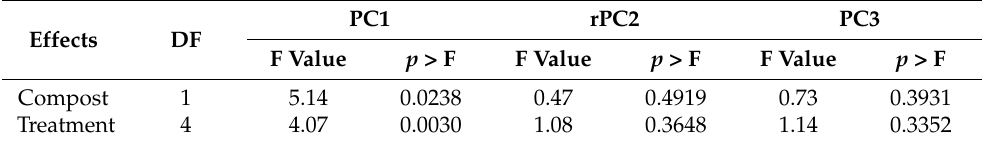
Table 3. Levene’s test of variance homogeneity for PC1, Gaussian transformed PC2 (rPC2) and PC3.